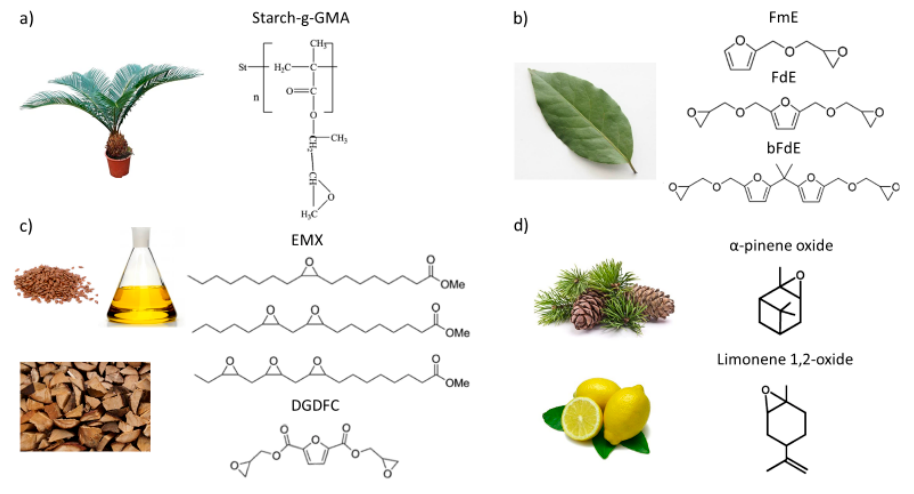
Figure 7. Some examples of epoxidized monomer/polymer structures derived from different biobased resources. ( a ) Starch-g-GMA; ( b ) epoxidized furanic compounds FmE, FdE, and bFdE; ( c ) diglycidyl furan-2,5-dicarboxylate (DGFDC) and different epoxidized fatty acid methyl esters (EMX); ( d ) α -pinene oxide and 1,2-oxide (LMO). Starch is one of the most abundant and readily available carbohydrates in the world.